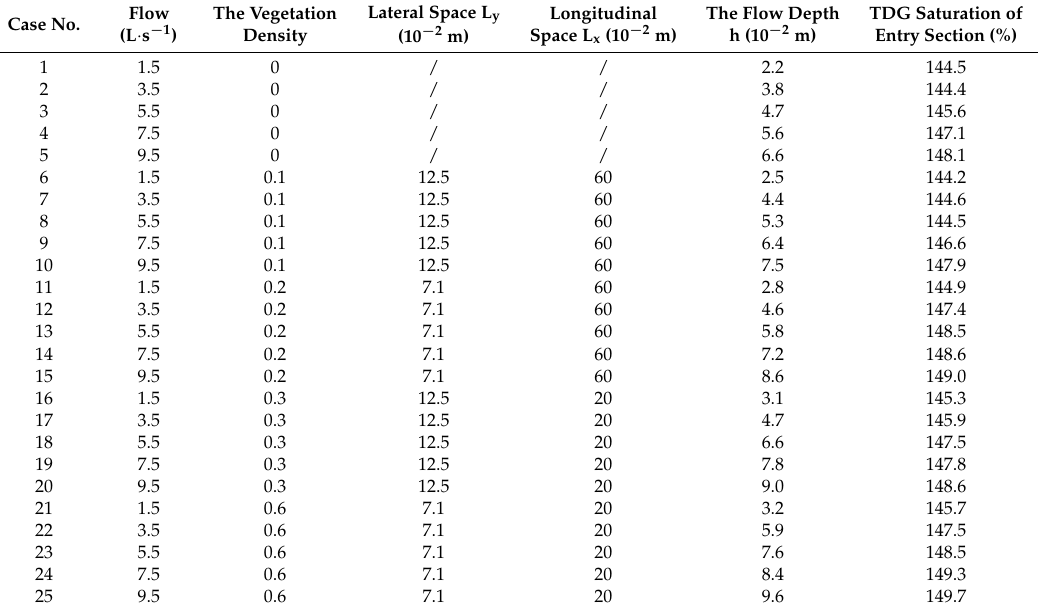
Figure 2. The arrangement of Plexiglas columns in the experimental flume. Table 1. The conditions of experimental cases.